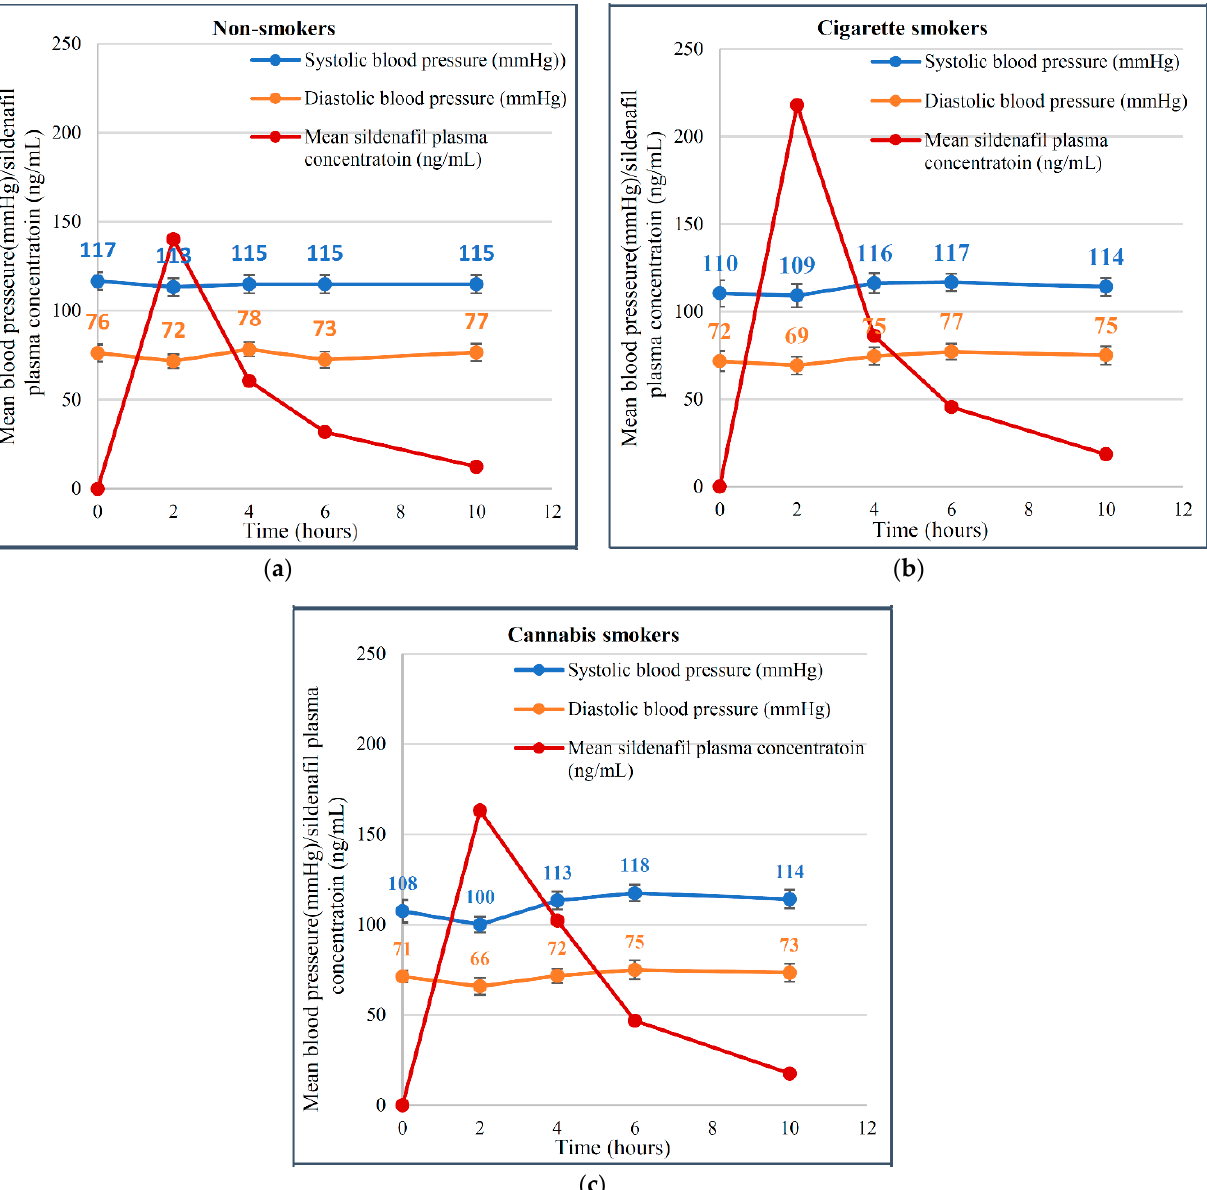
Figure 3. Mean blood pressure (systolic/diastolic) co-plot with mean sildenafil plasma concentration versus time after the oral administration of a single 50 mg dose of sildenafil tablets in each group: ( a ) non-smokers; ( b ) cigarette smokers; ( c ) cannabis smokers.